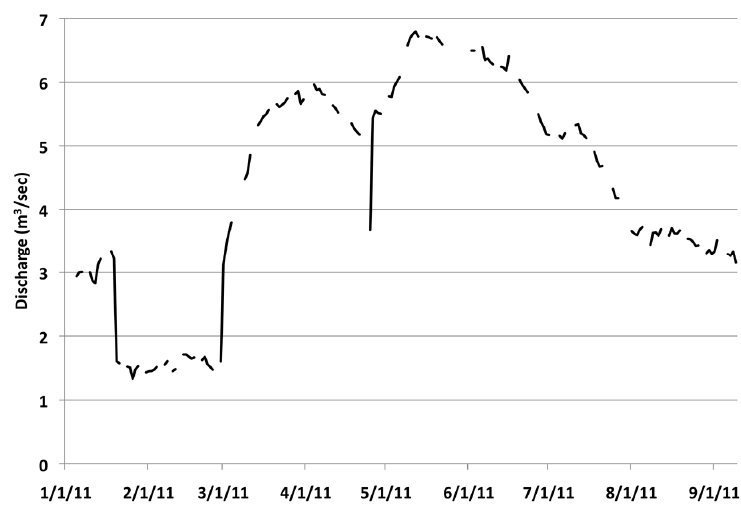
Figure 8. Discharge of Mississippi River from the Violet Siphon during the study.